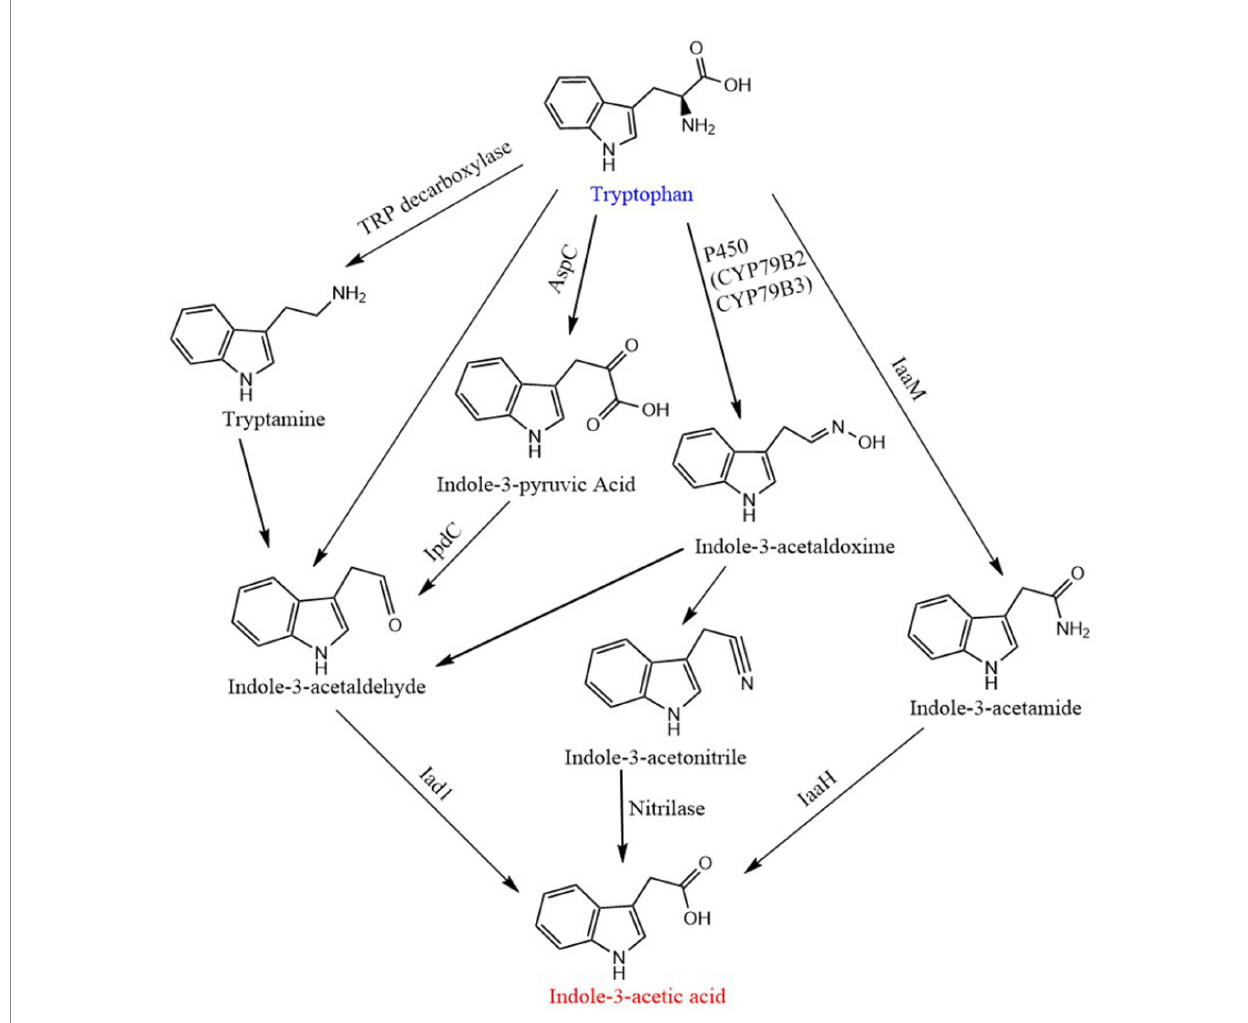
FIGURE 5 Biosynthetic pathway of in-dole-3-acetic acid. CYP79B2 and CYP79B3, cytochrome P450 monooxygenase; AapC, aminotransferase; Ipdc, indole-3- pyruvic acid decarboxylase; Iad1, indole-3-acetic acid dehydrogenase; IaaM, tryptophan 2-monooxygenase; IAAH, IAM